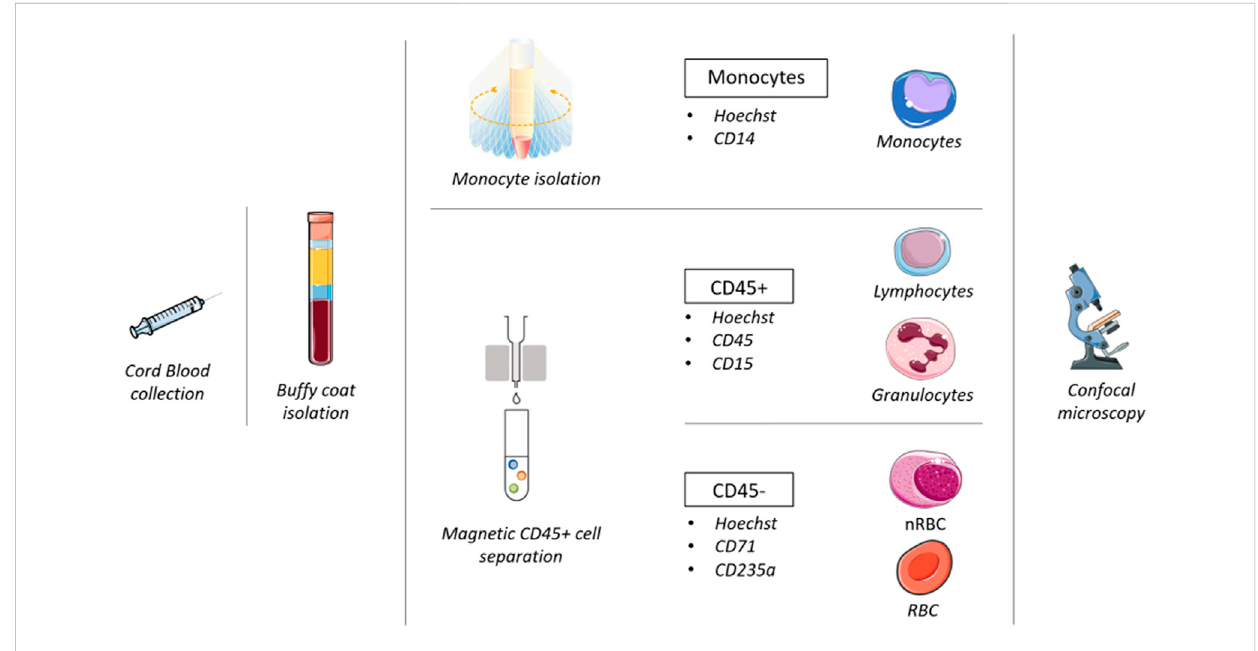
FIGURE 1 Work fl ow followed in this study.